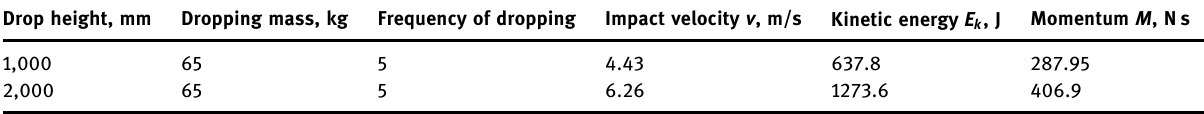
Table 2: Characteristics of impact force